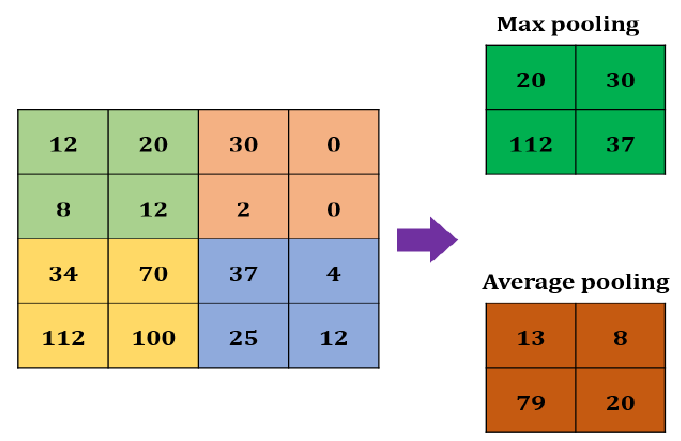
Figure 3. Max pooling in CNN.